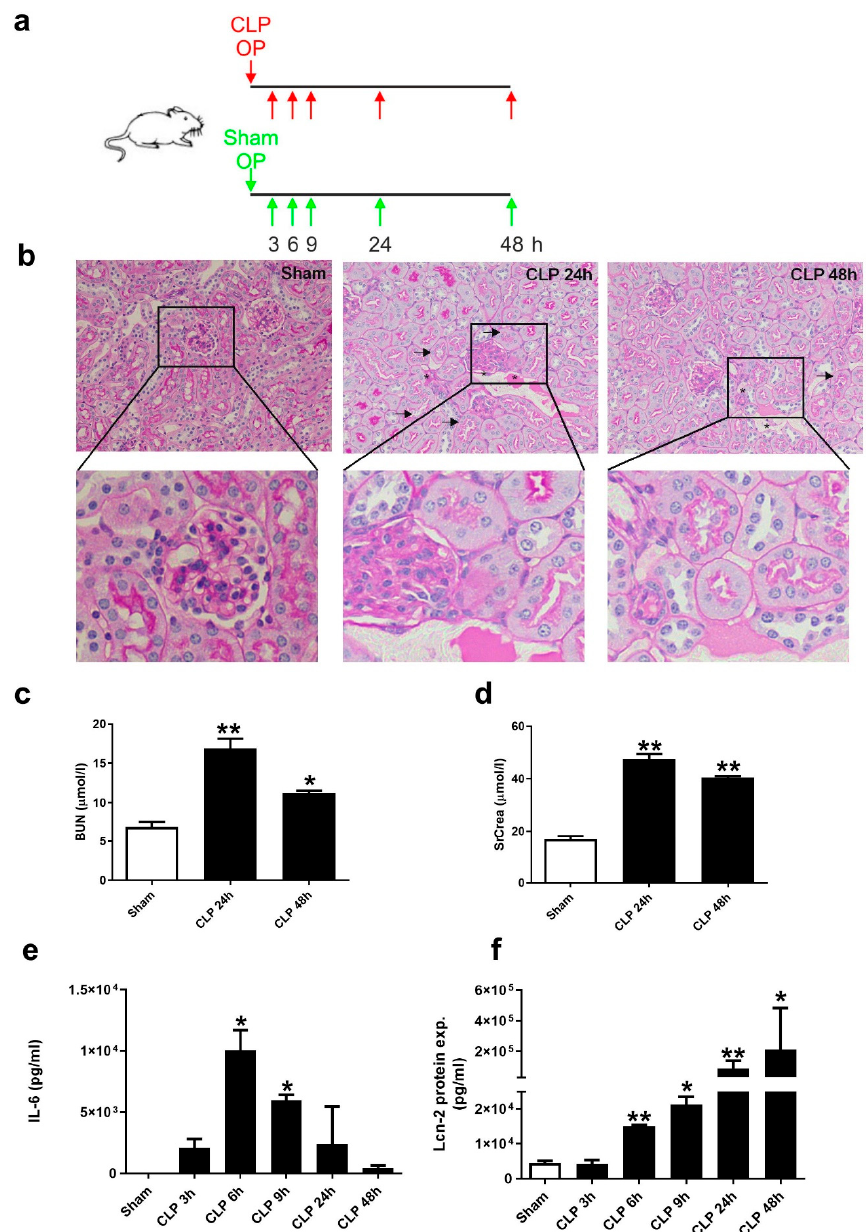
Figure 1. Cecal ligation and puncture (CLP)-induced sepsis promotes kidney damage. ( a ) Schematic overview of the experimental setup of the CLP-model. Sham-operated animals were used as controls. Arrows indicate the time-points of harvesting both blood (3, 6, 9, 24, and 48 h) and kidneys (24 and 48 h) for further processing. ( b ) Histologic analysis of tissue damage applying PAS staining. Pictures are representative of 5 animals in each group. ( c ,d) Analysis of kidney injury markers ( c ) blood urea nitrogen (BUN) (n = 5 animals per group; one-way ANOVA followed by Tukey’s multiple comparison test) and ( d ) SrCrea (n = 5 animals per group; one-way ANOVA followed by Tukey’s multiple comparison test). ( e ) Measurement of IL-6 in serum applying cytometric Bead Array (CBA) (n = 6 animals for 3, 6, and 9 h; n = 5 animals per group for 24 and 48 h; Kruskal-Wallis test followed by Dunn’s post-hoc test). ( f ) Analysis of Lcn-2 protein expression in serum using ELISA (n = 6 animals for 3, 6, and 9 h; n = 5 animals per group for 24 and 48 h; one-way ANOVA followed by Tukey’s multiple comparison test). * p < 0.05, ** p <